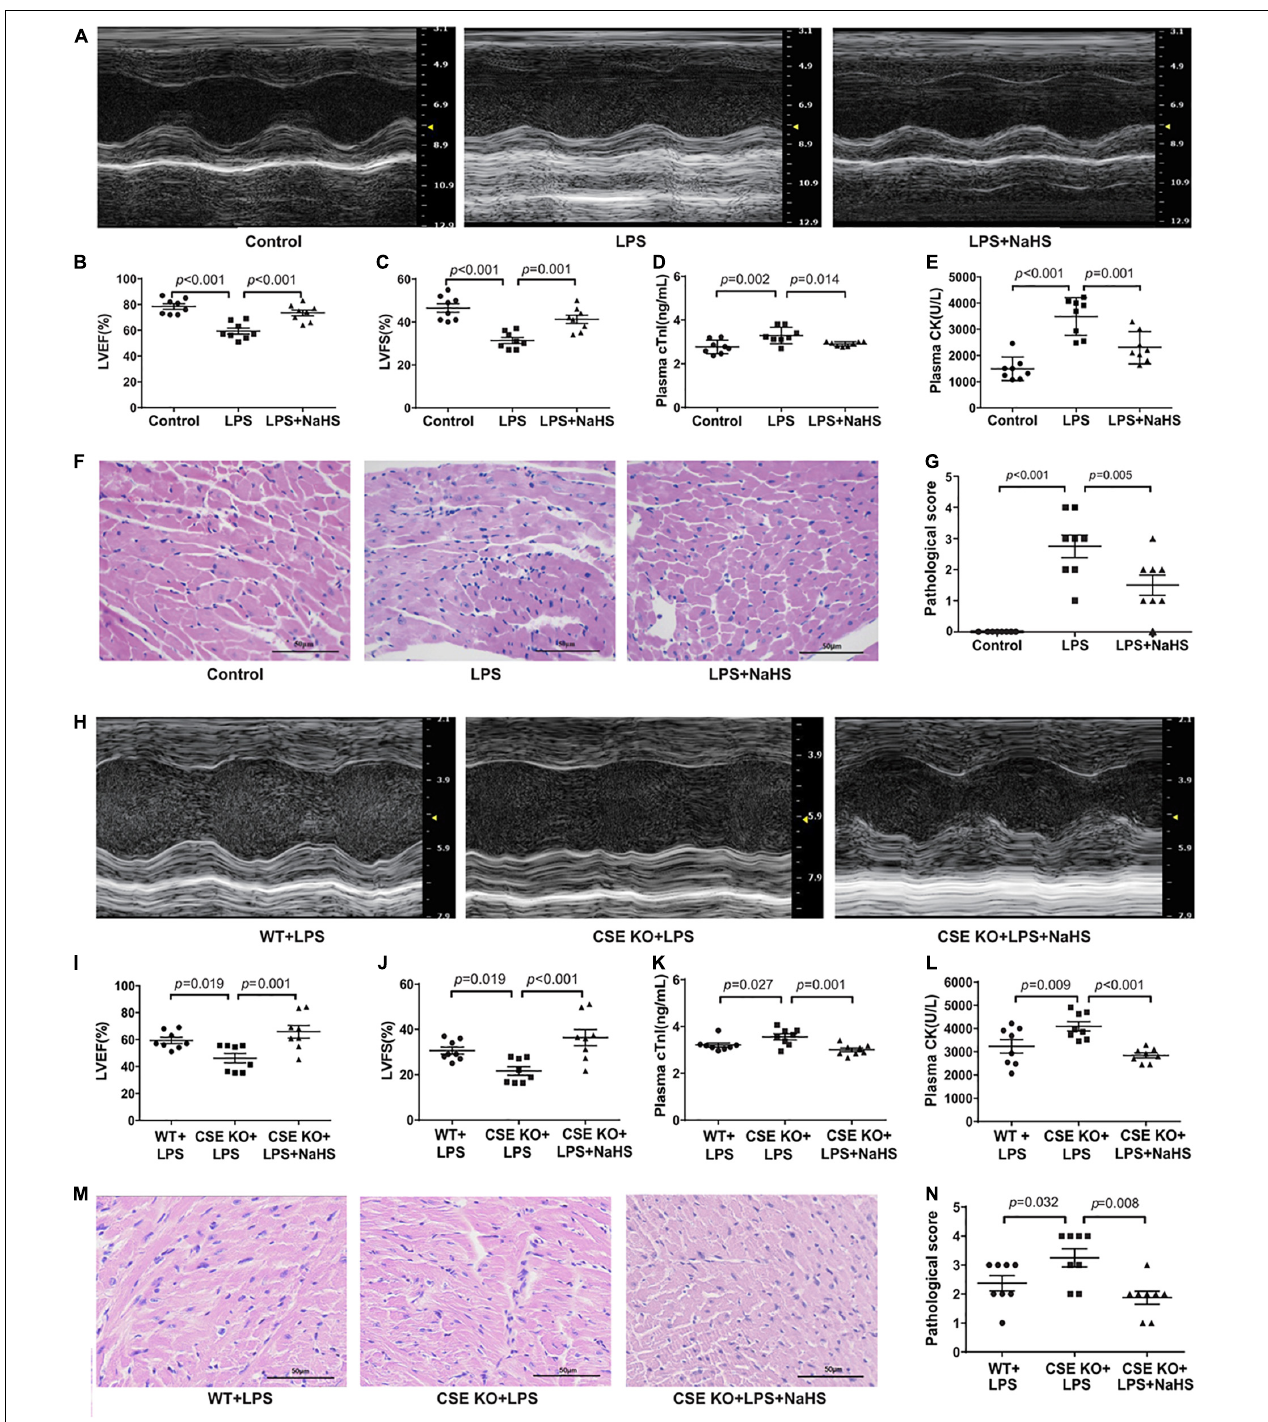
FIGURE 4 | Exogenous H 2 S ameliorated LPS-induced myocardial dysfunction: (A) Representative M-mode images from the Control, LPS, and LPS + NaHS groups. (B) The changes of left ventricular ejection fraction (LVEF). (C) The changes of left ventricular fractional shortening (LVFS). (D) cTnI levels in the plasma. (E) CK levels in the plasma. (F) Representative HE-stained left ventricular sections (scale bar = 50 µ m). (G) Pathological score of the HE-stained left ventricular sections. (H) Representative M-mode images from the WT + LPS, CSE KO + LPS, and CSE KO + LPS + NaHS groups. (I) The changes of left ventricular ejection fraction (LVEF). (J) The changes of left ventricular fractional shortening (LVFS). (K) cTnI levels in the plasma. (L) CK levels in the plasma. (M) Representative HE-stained left ventricular sections (scale bar = 50 µ m). (N) Pathological score of the HE-stained left ventricular sections. n = 8 in every group. Results are means ± SEM. p < 0.05 was considered